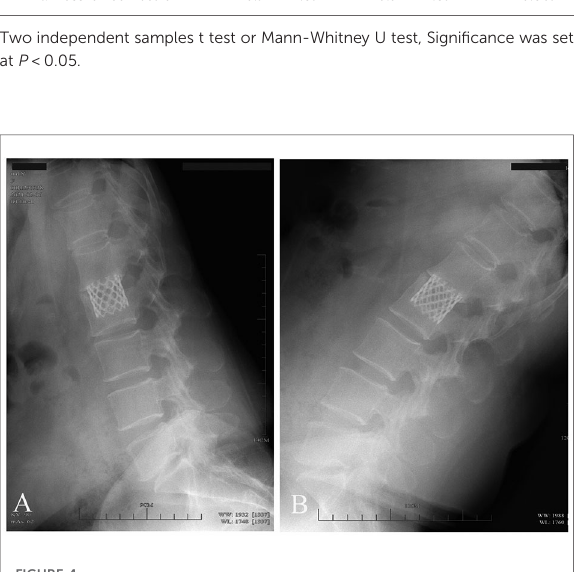
FIGURE 4 Spinal hyperextension – hyper fl exion ( A,B ) A patient with L2 fracture showing good segmental mobility after removal of posterior internal fi xation.